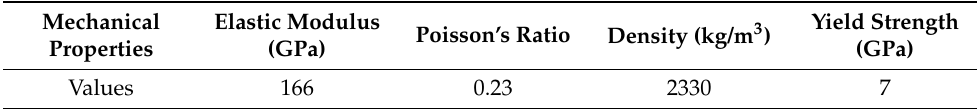
Table 2. Mechanical properties of single-crystal